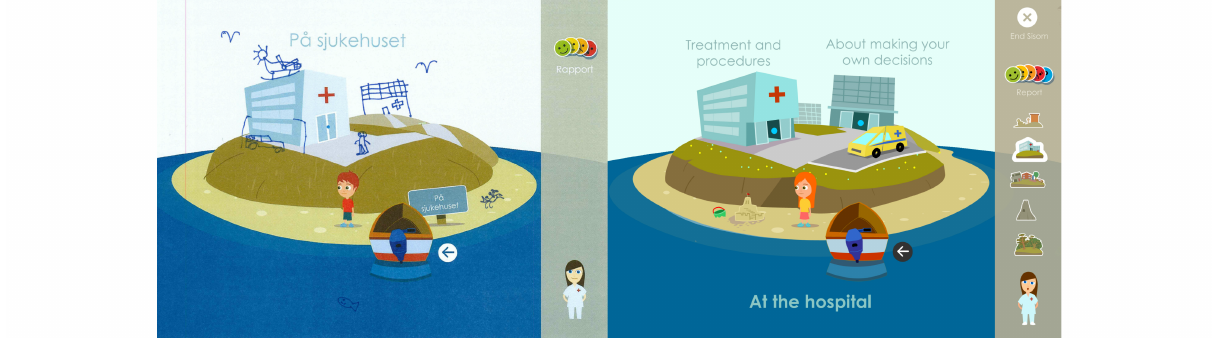
Figure 5. The children suggested that the pictures in Sisom should have more details. Left: an example of what a child drew on a screenshot; Right: the final version in Sisom